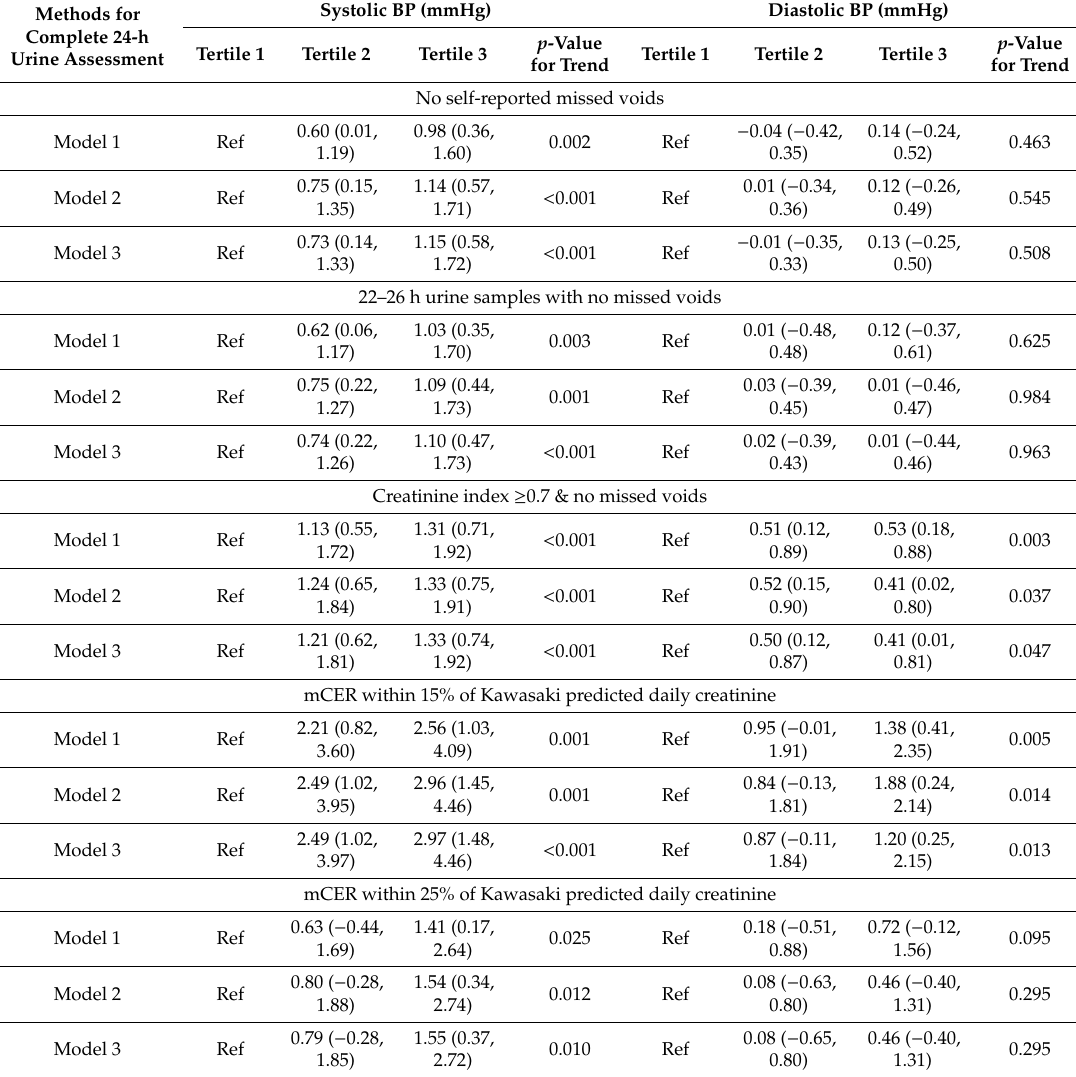
Table 3. Association between the tertile of urinary sodium and blood